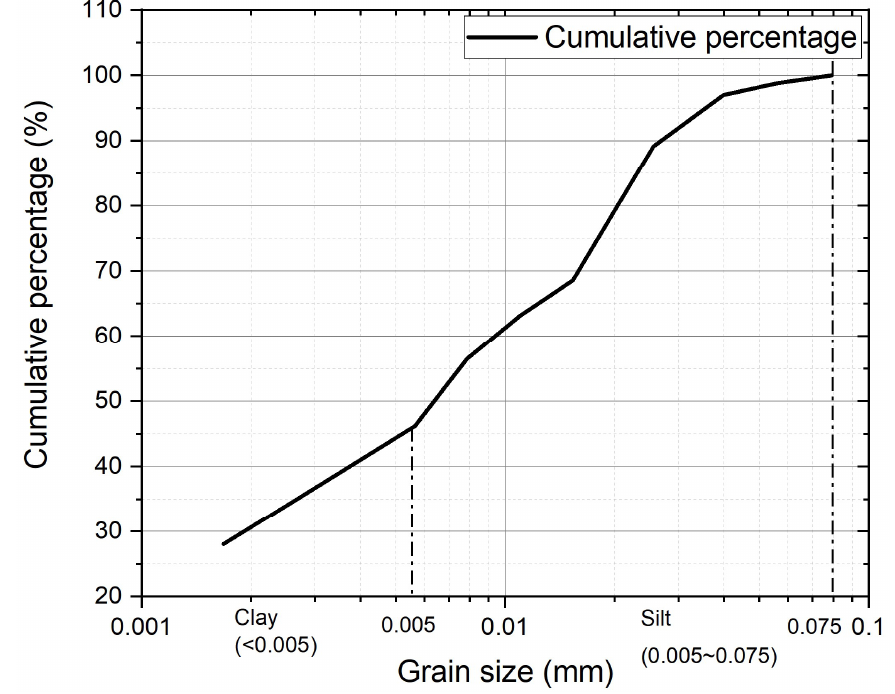
Figure 2. Grain distribution curve of the silty clay.